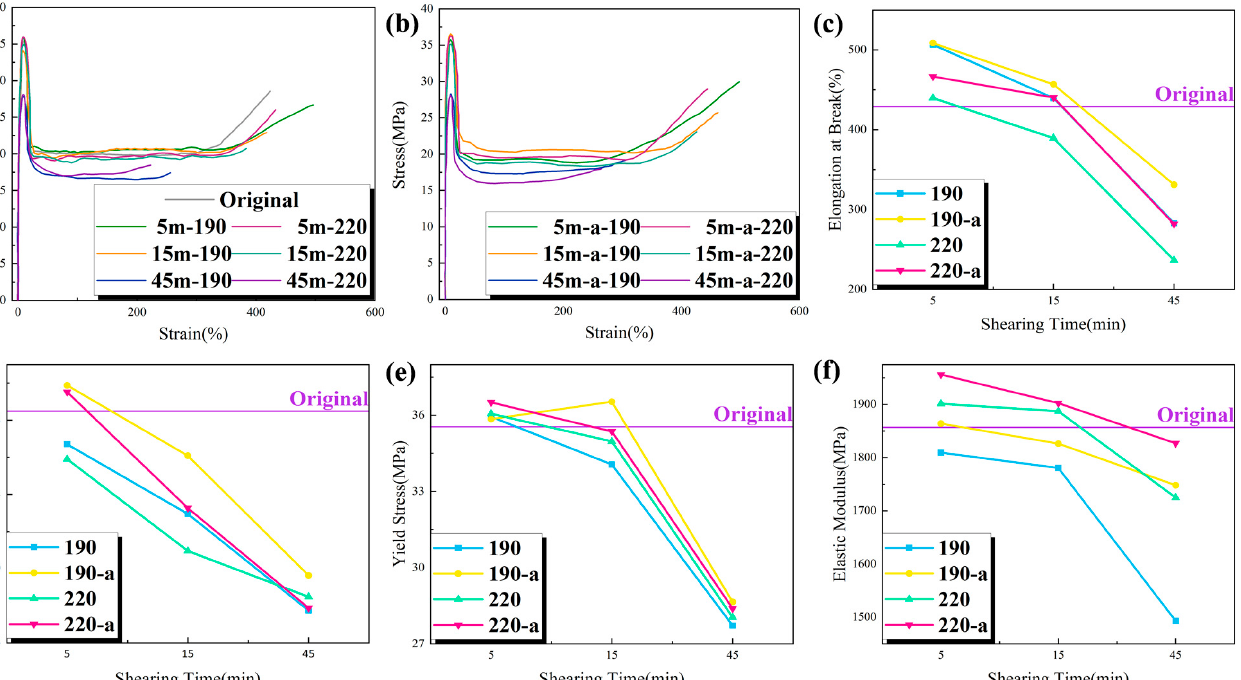
Figure 5. The thermal elongation of each sample under different shear at 150 °C.